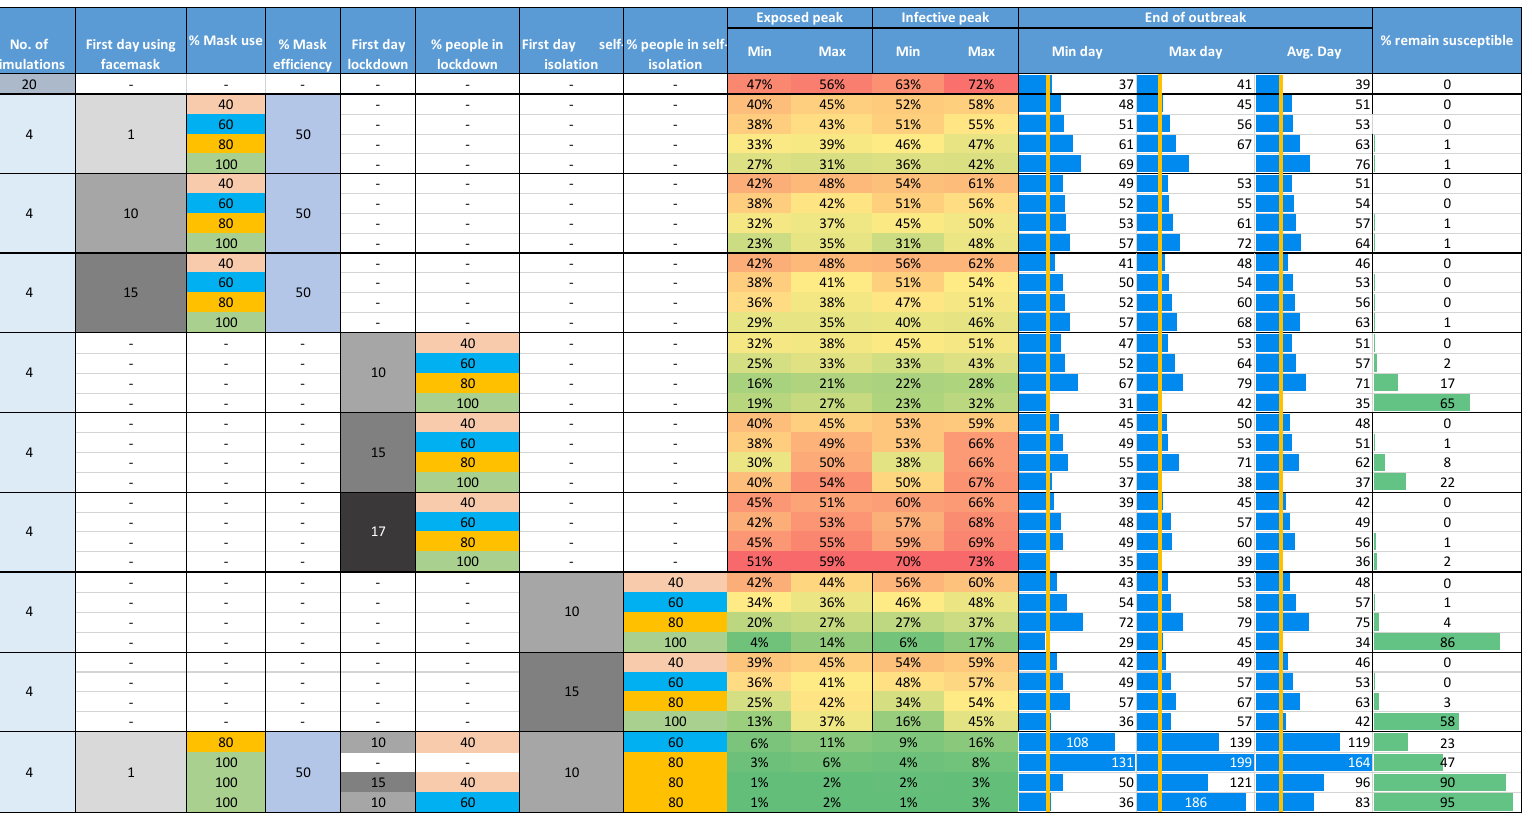
Figure A10. Result comparison of applied measures to reduce the risk.